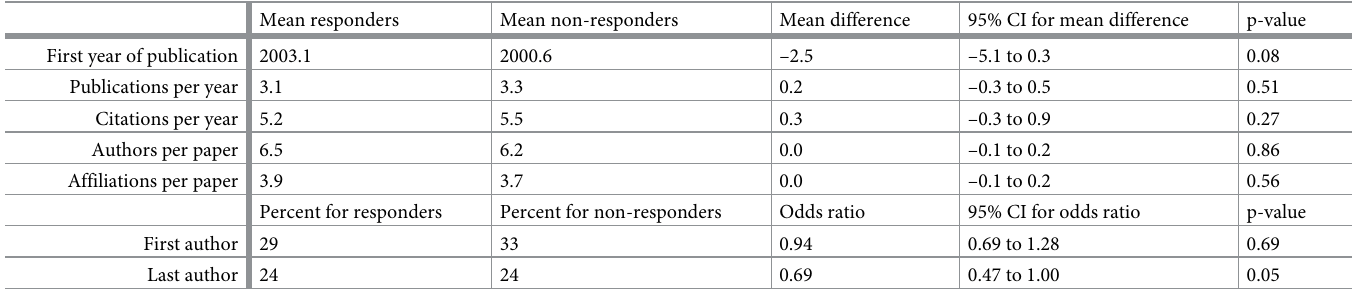
Table 2. Comparisons of responders ( n = 95) and non-responders ( n = 65) for the publication and collaboration outcomes. The denominator for the per paper statis- tics is 3, 845 papers. The per paper mean difference/odds ratio, confidence intervals and p-values are from a mixed regression model with a random intercept per